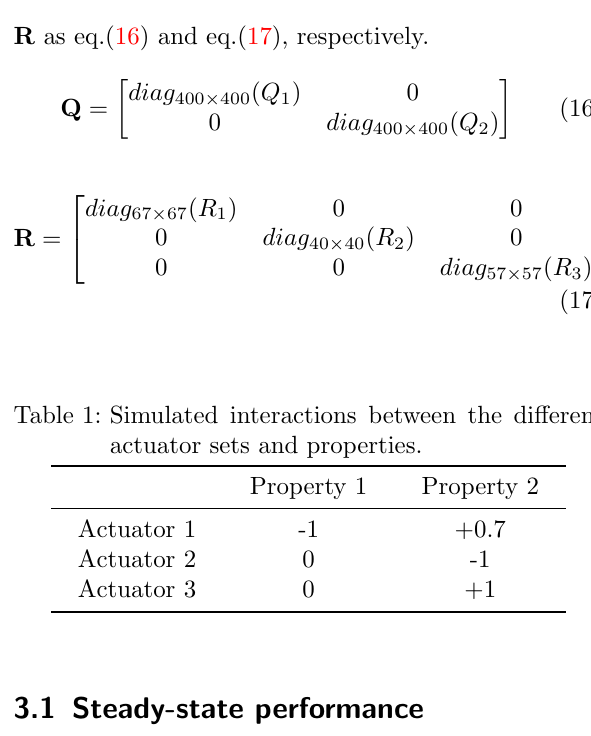
Figure 4: Actuator response shapes (on top) and dy- namics (on bottom) for three types of actu- ators. Dotted line is for Actuator 1, dashed line for Actuator 2 and solid line for Actuator 3.